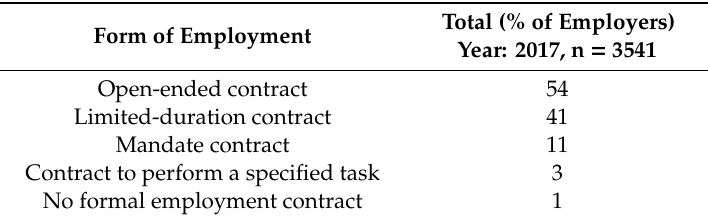
Table 2. Main forms of employment in key positions (Prokopowicz et al. 2018).